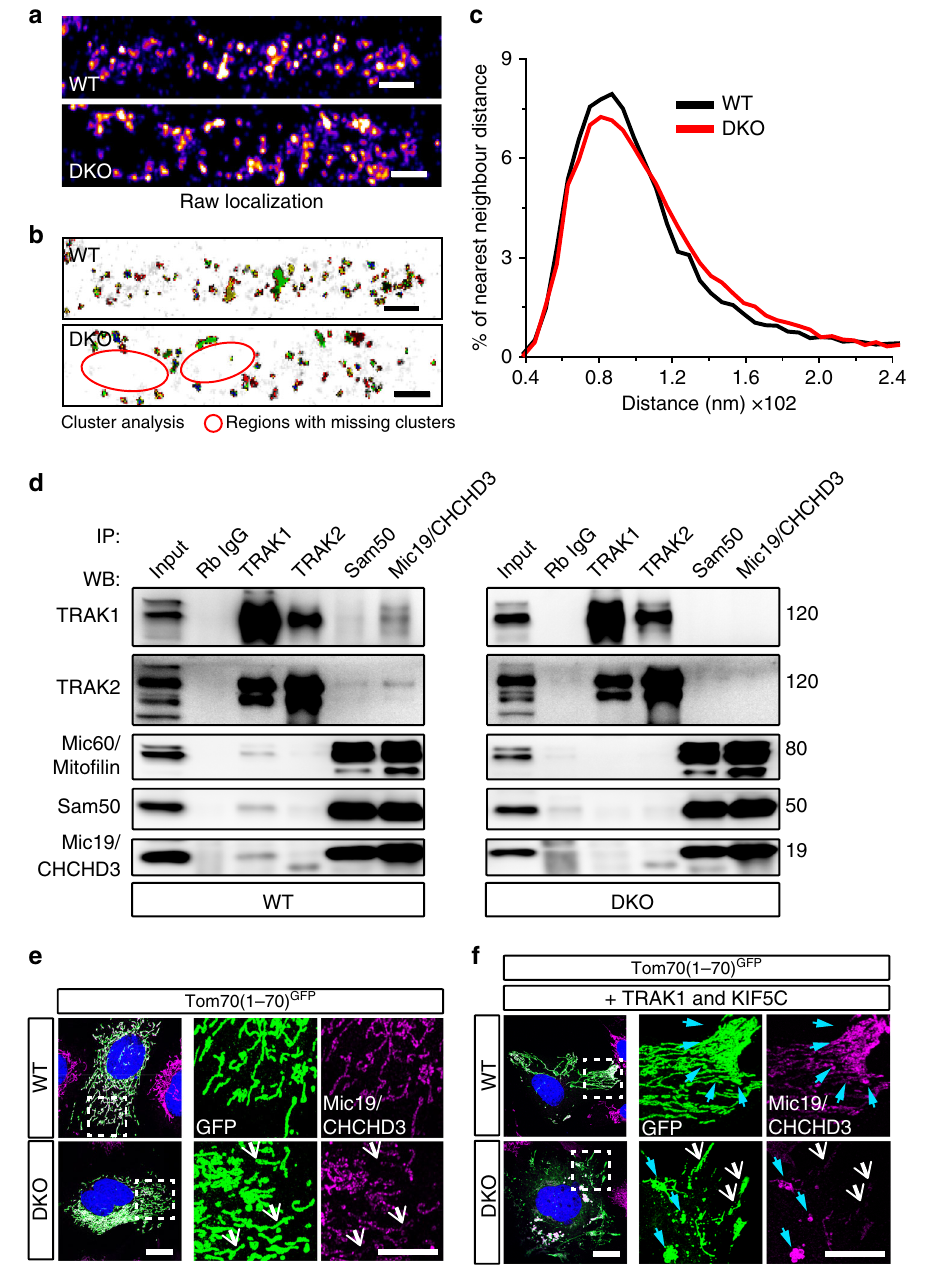
Fig. 6 Altered distribution of MICOS in Miro DKO cells due to the loss of cytoskeletal anchorage. a Distribution of MICOS (Mic19/CHCHD3) clusters along the mitochondrial membrane in WT and DKO cells. Pseudo-colored representation of reconstructed dSTORM images of MICOS complexes (scale bar: 0.5 μ m). b DBSCAN cluster map of Mic19/CHCHD3 clusters. DKO cells show the areas with depletion of clusters in comparison with WT cells (scale